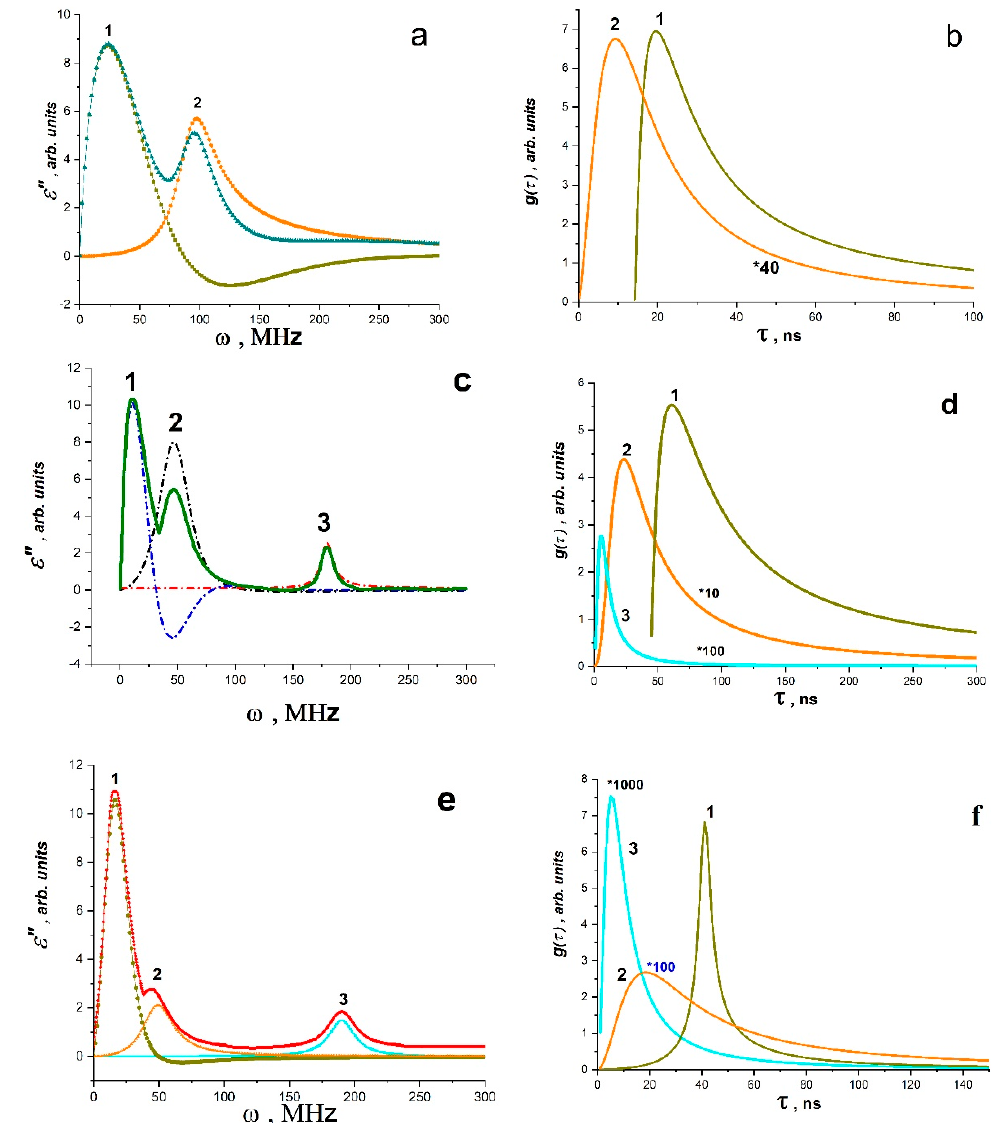
Figure 8. Dependence of permittivity ε ″ on frequency according to the Havriliak–Negami model for PS matrix ( a ), PS–BC Co ( c ), PS–BC Mn ( e ). Curves of the relaxation time distribution g ( τ ) for PS matrix ( b ), PS–BC Co ( d ), PS–BC Mn ( f ). The numbers of absorption bands and curves g ( τ ) correspond to the numbers in brackets in Table 2, ( f ) curves 2 and 3 y -axes multiplied by 100 and 1000 respectively (From [48] with permission).